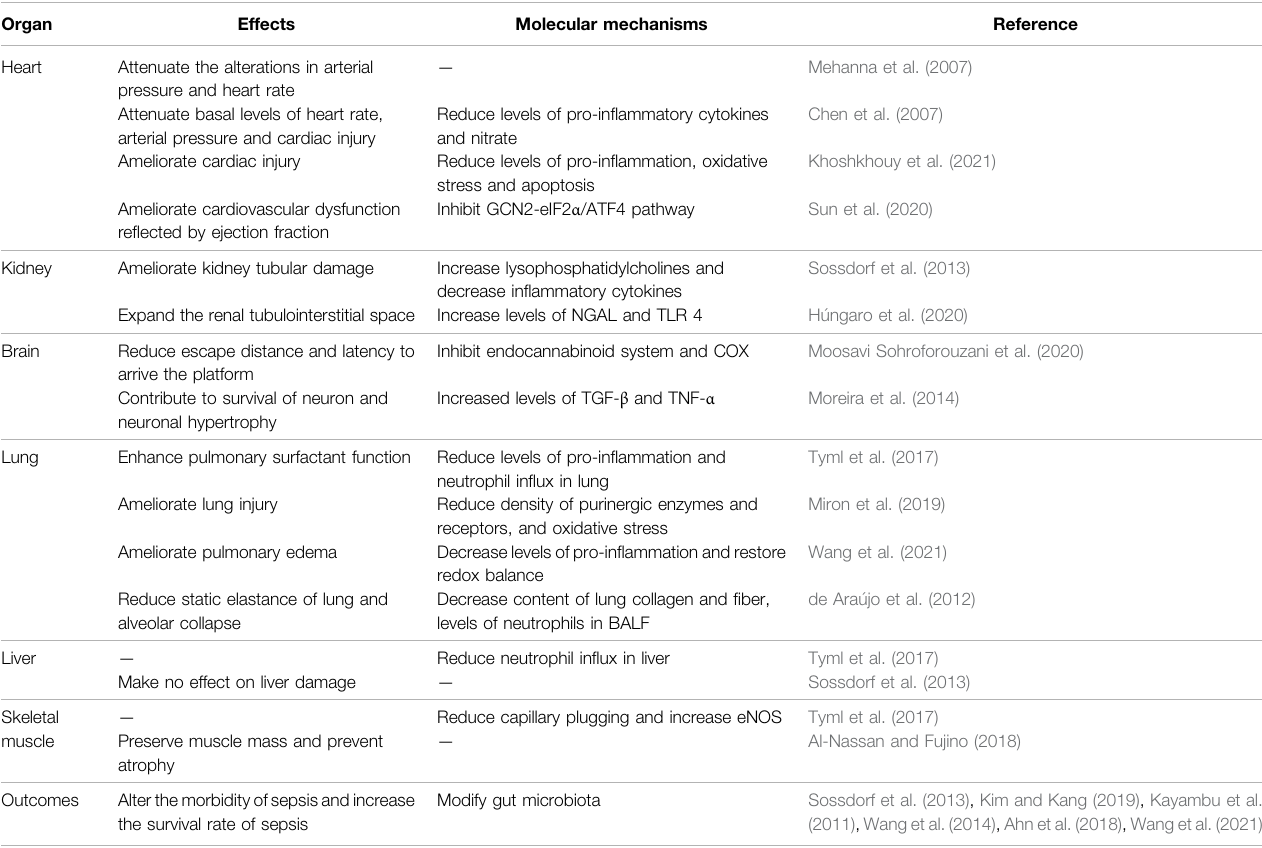
TABLE 1 | Effects of physical exercise on multiple organ function and outcomes of